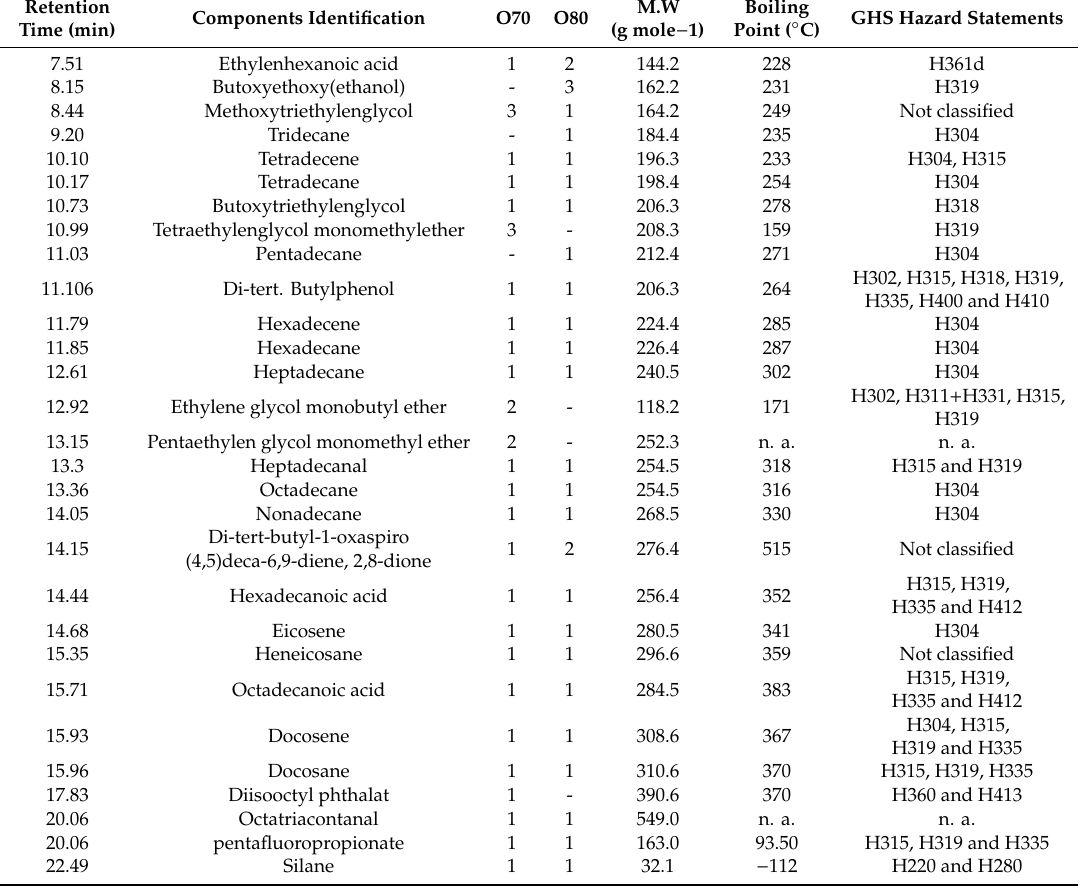
Table 2. Components of extracted oil